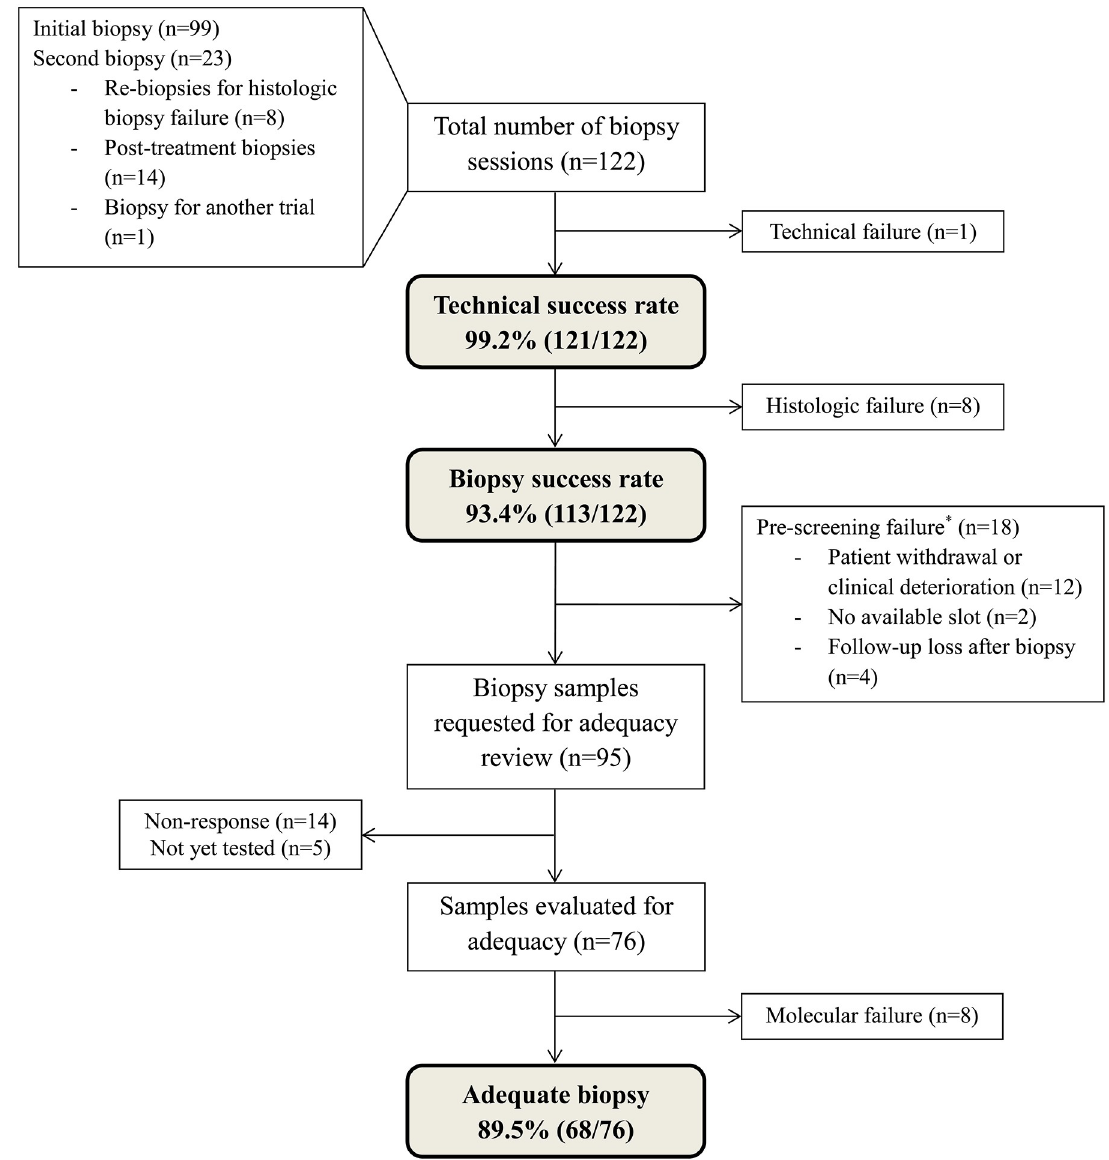
Fig 1. Patient flow diagram. Footnote: � The pre-screening failure cases were samples obtained from patients who met the eligibility criteria, signed an informed consent, underwent biopsy, but failed to start the study treatments.